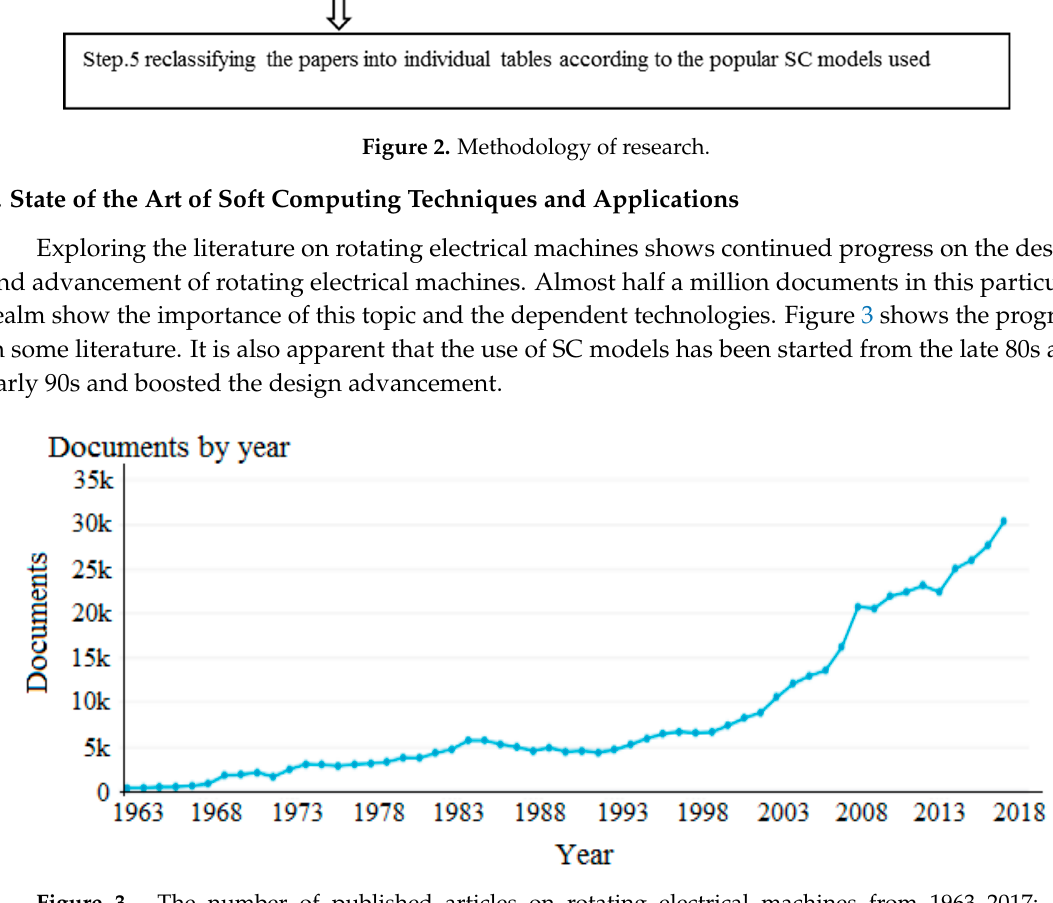
Figure 3. The number of published articles on rotating electrical machines from 1963–2017: 483,320 document results. (Source: Scopus & Web of Science).